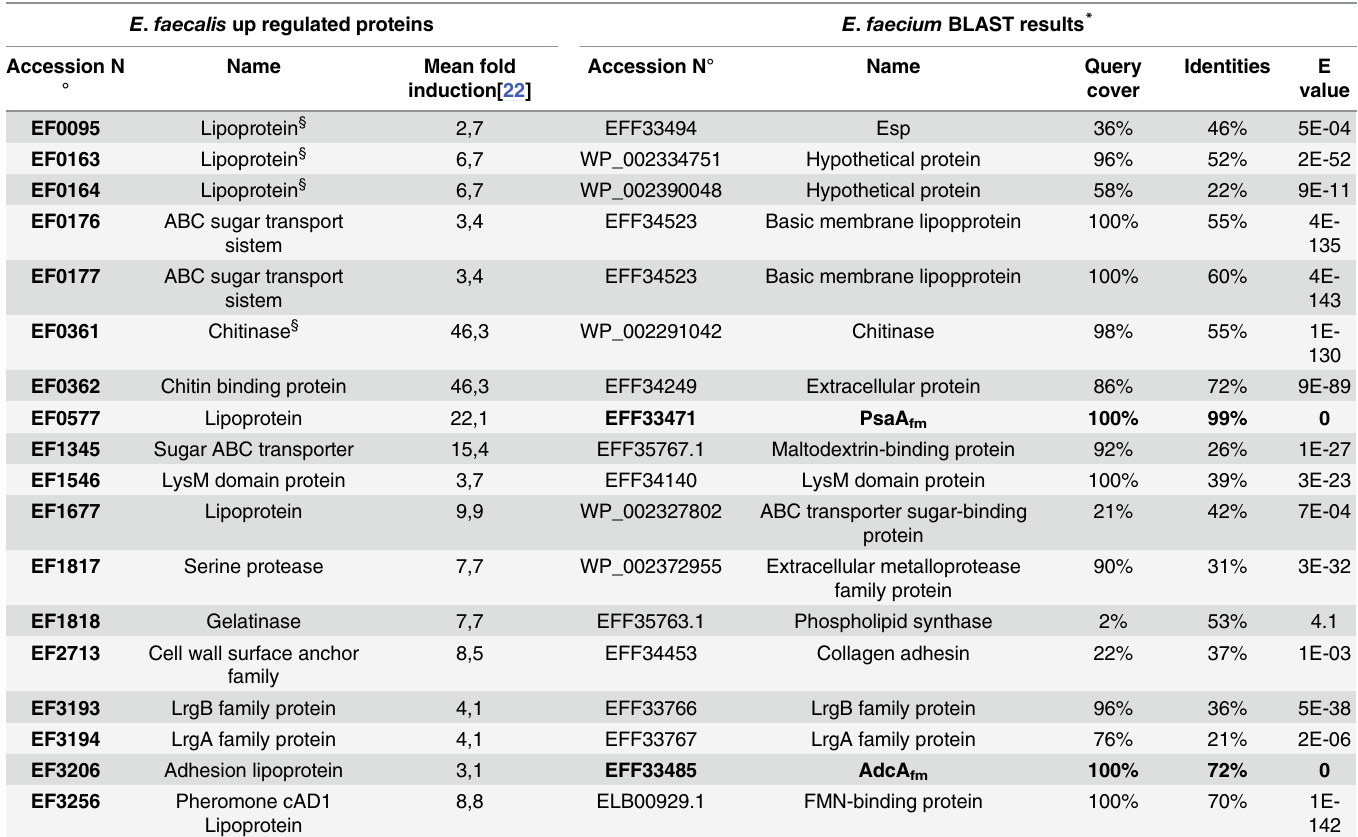
Table 3. Surface related proteins in E . faecalis up-regulated in the mice peritonitis model and corresponding BLAST homologies in E . faecium sequences.